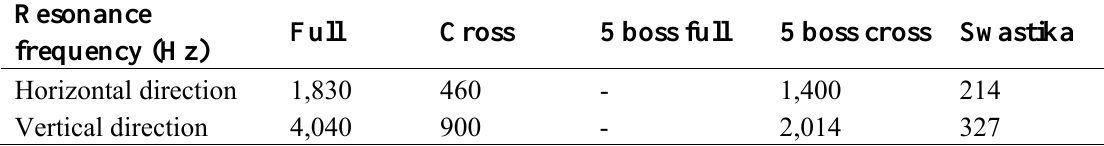
Table 5 . Resonance frequency for all the designs.